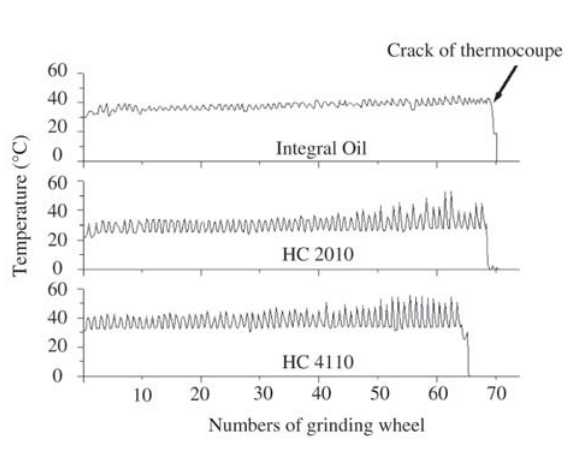
Figure 5. EA comparative results for the fluids.